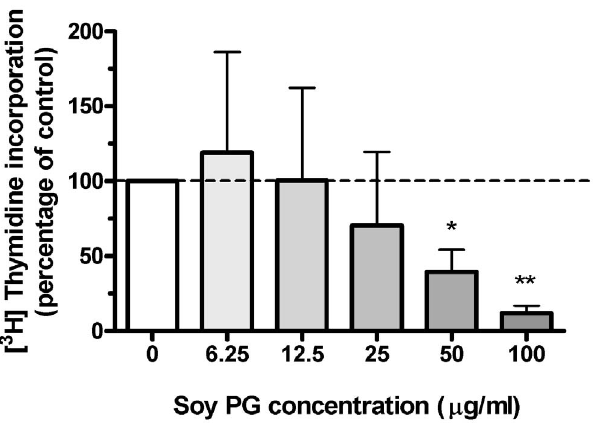
Figure 3. Effects of soy PG on keratinocyte proliferation. Near- confluent keratinocytes were treated for 24 hrs with the indicated concentrations of soy PG liposomes, prepared via bath sonication of the phospholipid in SFKM. [ 3 H]Thymidine incorporation into DNA was then determined as above. Values represent the means 6 SEM of 5 separate experiments performed in duplicate; *p , 0.05, **p , 0.01 versus the control value (0 m g/). [ 3 H]Thymidine incorporation into DNA in the control was 62,600 6 8,000 cpm/well.